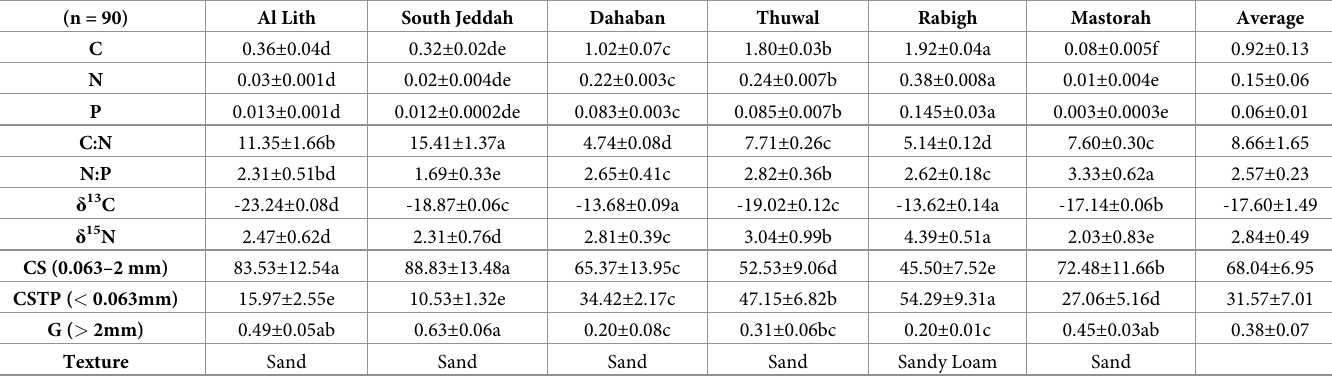
Table 4. Mean ( ± SE) of nutrients concentrations (%) in mangrove sediment and grain size at 6 sites on the coast of the central Red Sea, Saudi Arabia.